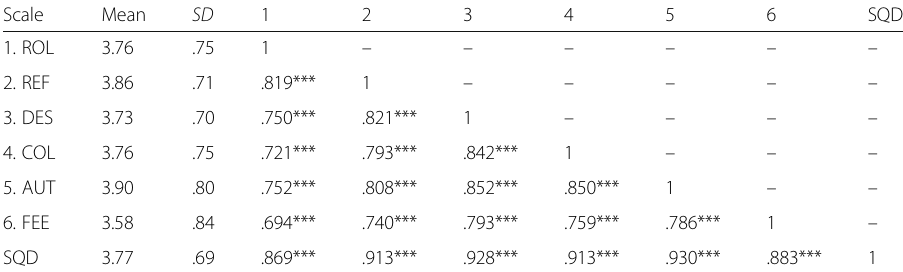
Table 3 Descriptive Statistics and Correlations among SQD and Its